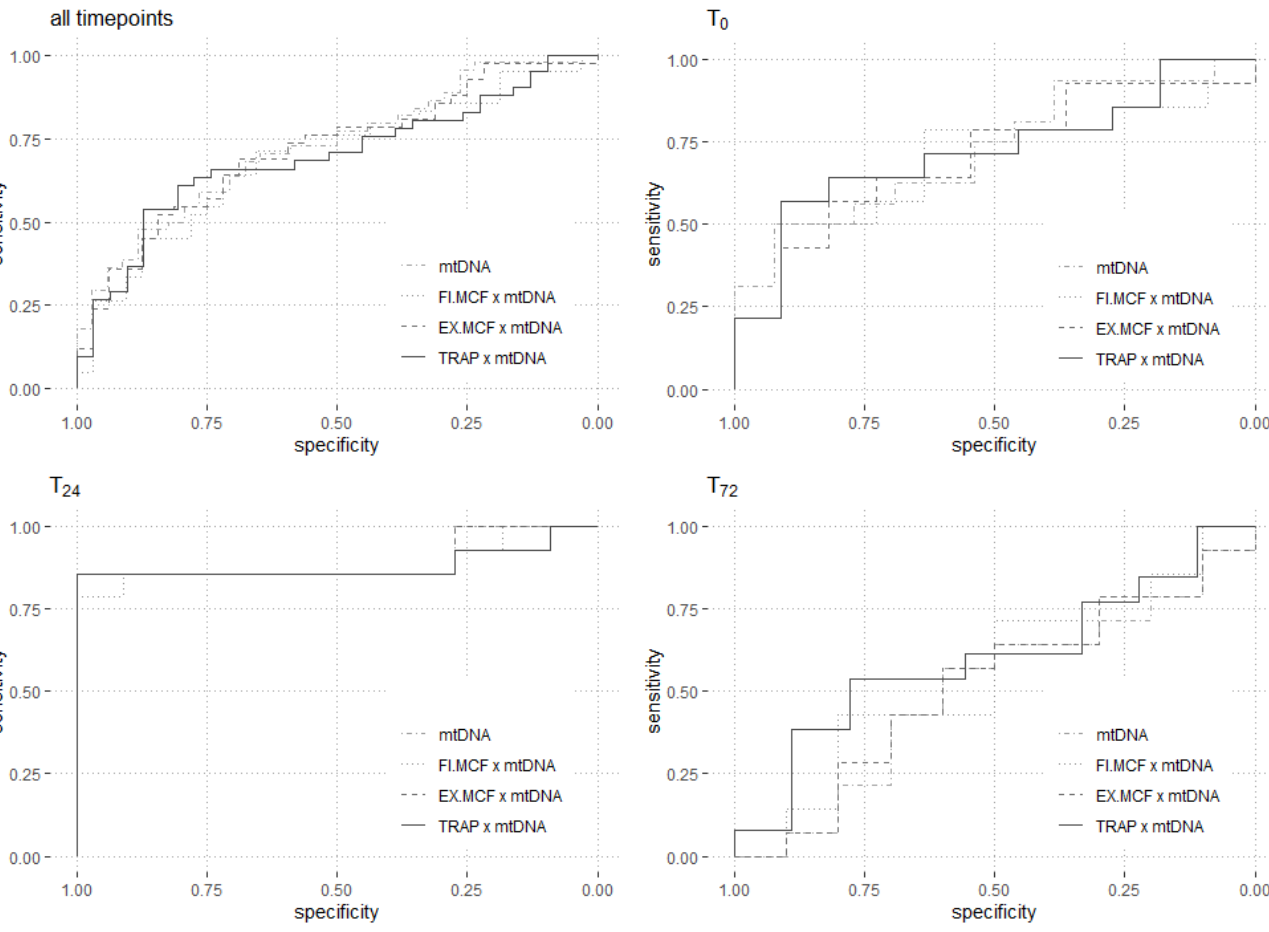
Figure 4. Prediction of in-hospital mortality. The receiver operating characteristic curves for the mtDNA level, FIBTEM MCF × mtDNA level, EXTEM MCF × mtDNA level and TRAP × mtDNA level are shown. The curves are presented for each time point (t 0 , t 24 and t 72 ) individually, as well as for all time points. Abbreviations: EX.MCF = maximum clot firmness in the extrinsically activated thromboelastometry assay; FI.MCF = maximum clot firmness in the fibrinogen-based thromboelas- tometry assay; mtDNA = mitochondrial DNA; TRAP = thrombin receptor-activating